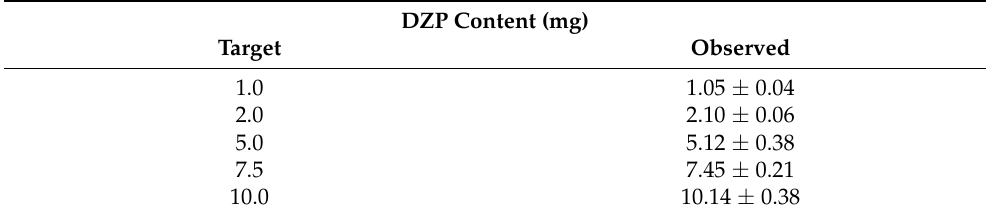
Table 3. Diazepam (DZP) content in tablets ( n = 6).